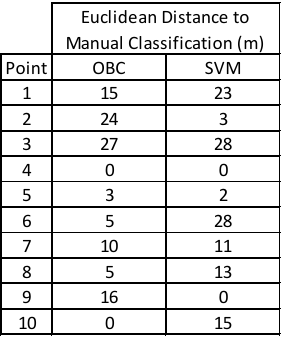
Table 1. Euclidean distances of random points on manual digitizing result to OBC and SVM classification